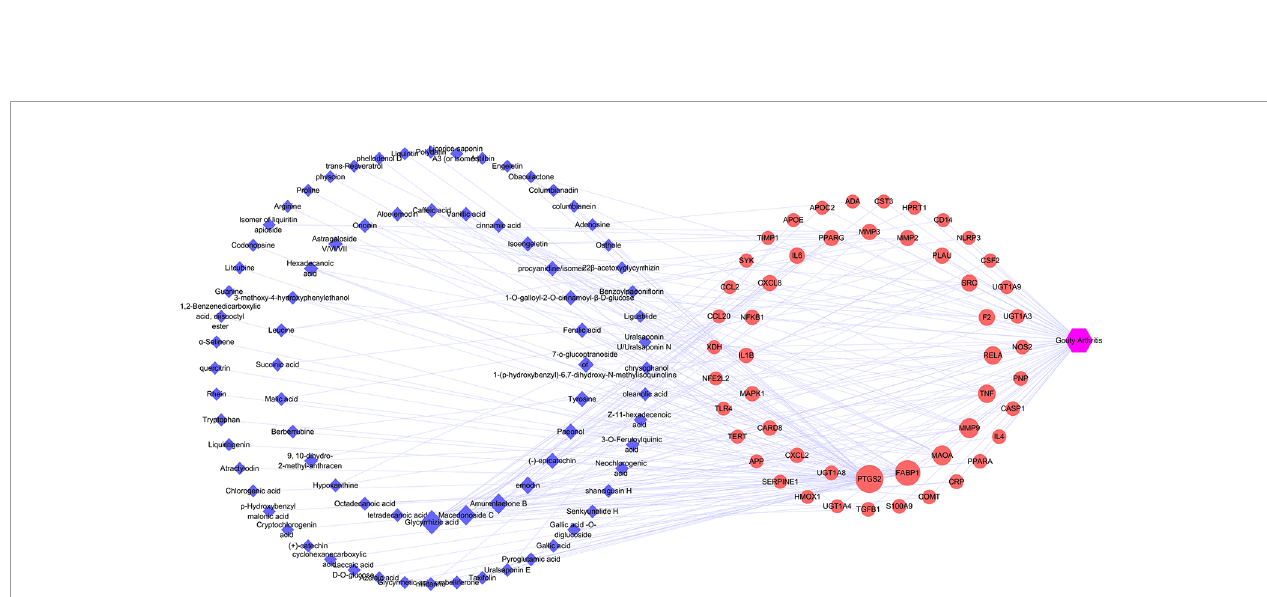
FIGURE 3 | Gouty arthritis-related targets of protein-protein interaction (PPI) network (Con fi dence score >0.95, Node size represent the degree).